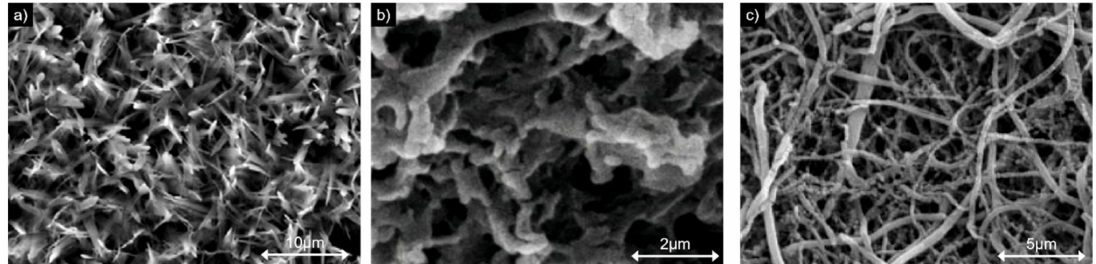
Figure 5. Morphologies of samples: ( a ) TiZr; ( b ) TiZr / PLA; ( c ) TiZr / PLA-PCL +